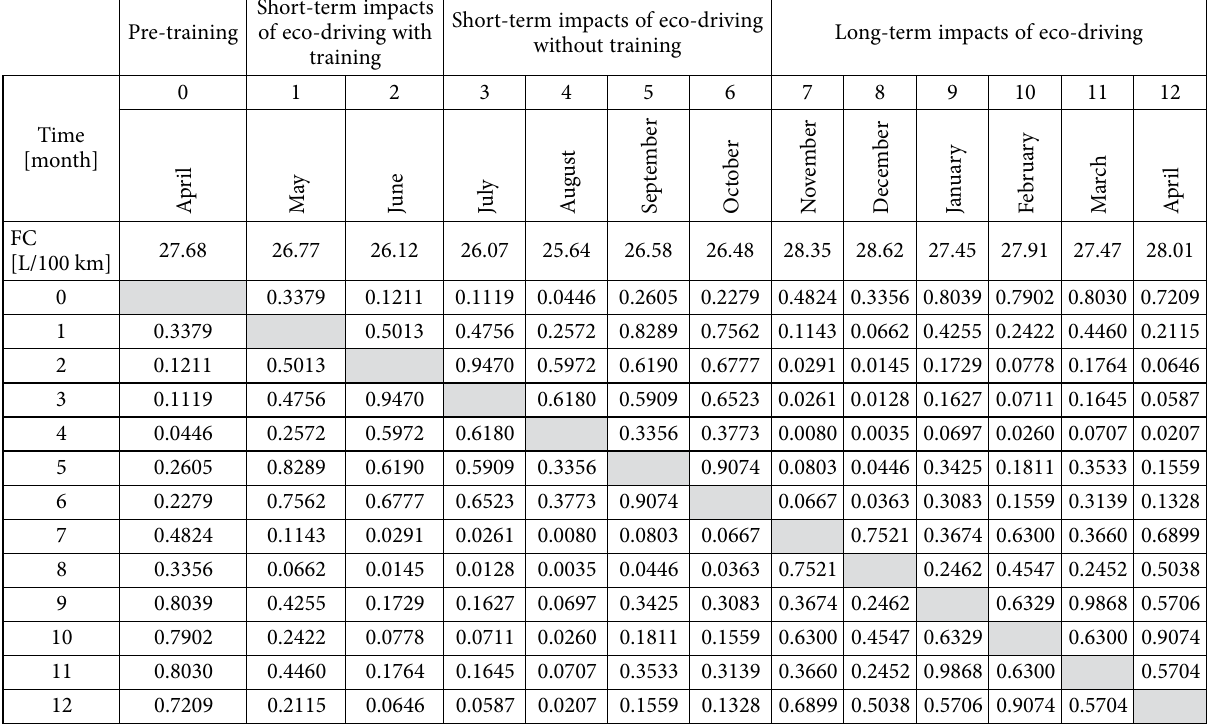
Table 4. p -values from post-hoc Duncan’s test for ANOVA for all average monthly values of the FC during the observed period Short-term impacts Short-term impacts of eco-driving Long-term impacts of Pre-training of eco-driving with without training training